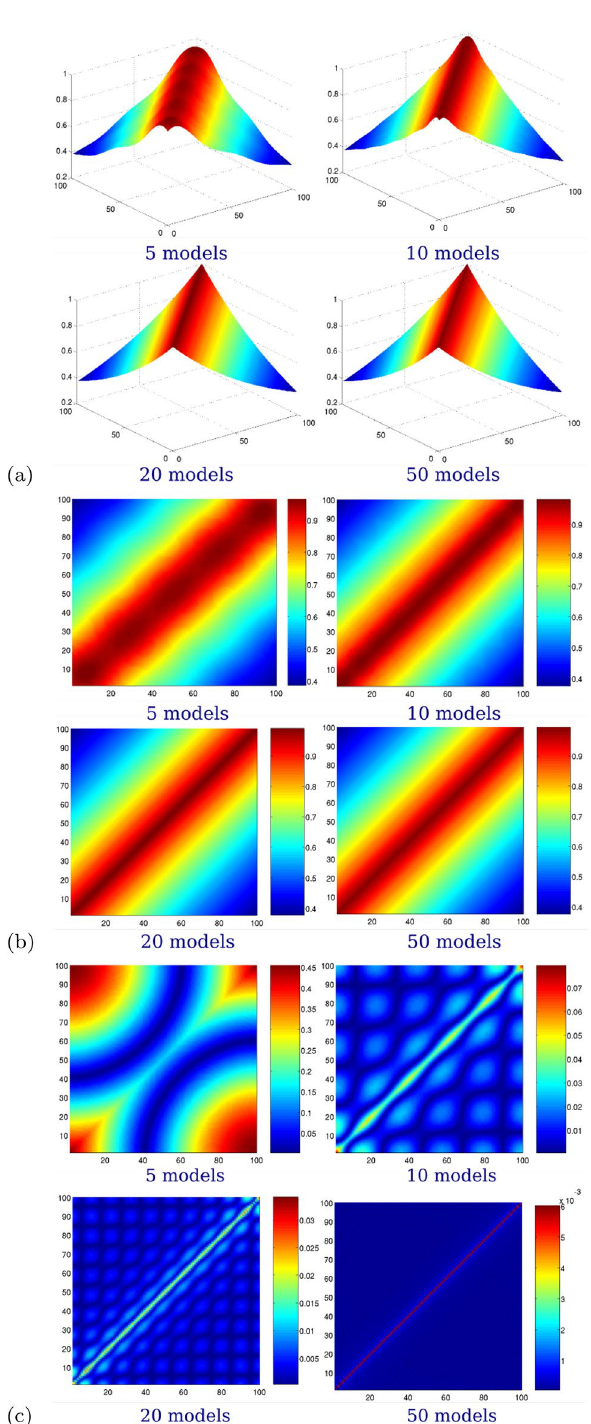
Fig. 25 Random field covariance obtained from 5, 10, 20 and 50 modes in truncated KLE expansion: a 3D representation; b 2D rep- resentation and c representation